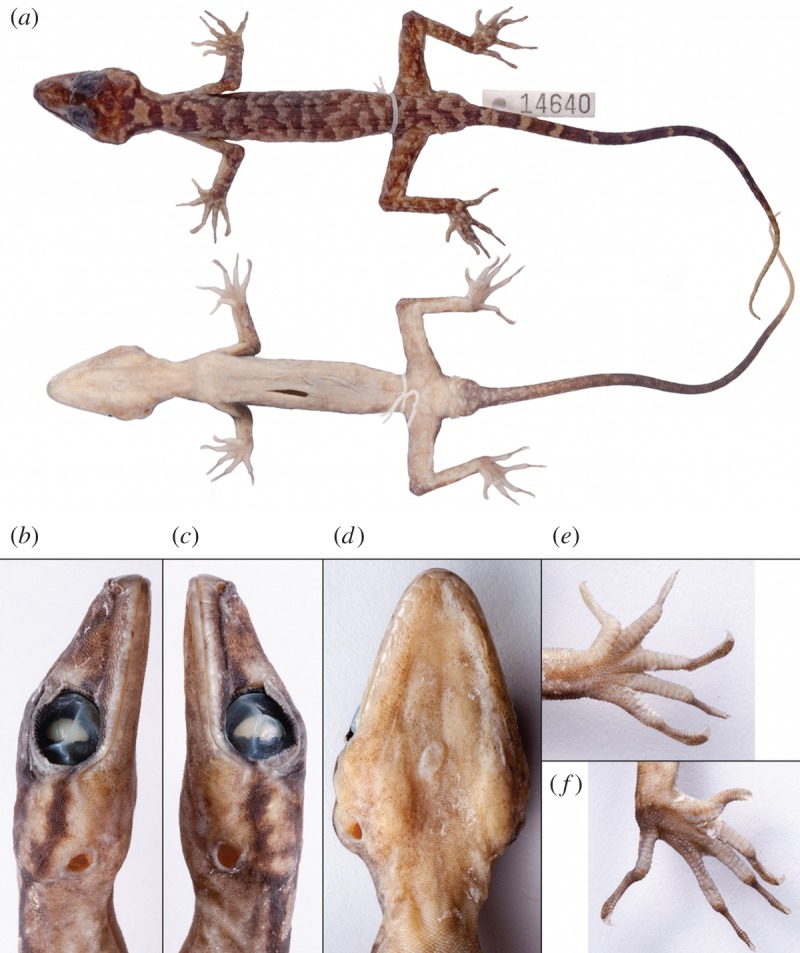
Holotype of Cyrtodactylus tanim n. sp. NMV75956, showing the dorsal and ventral aspects of the habitus (a), the right (b), left (c) and ventral (d) aspects of the head, and the plantar surfaces of the left manus (e) and pes (f).